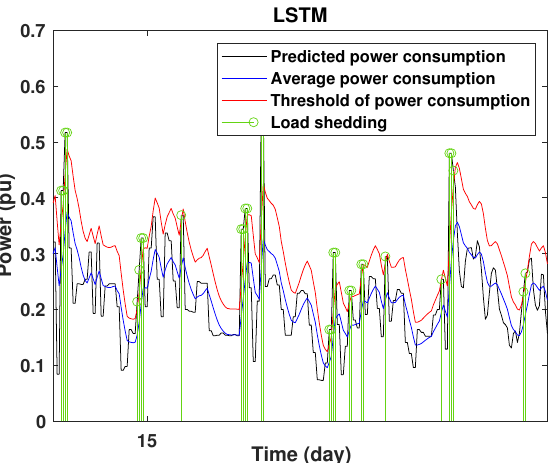
Figure 20. Detection of power consumption peaks during 1 day using the LSTM model.